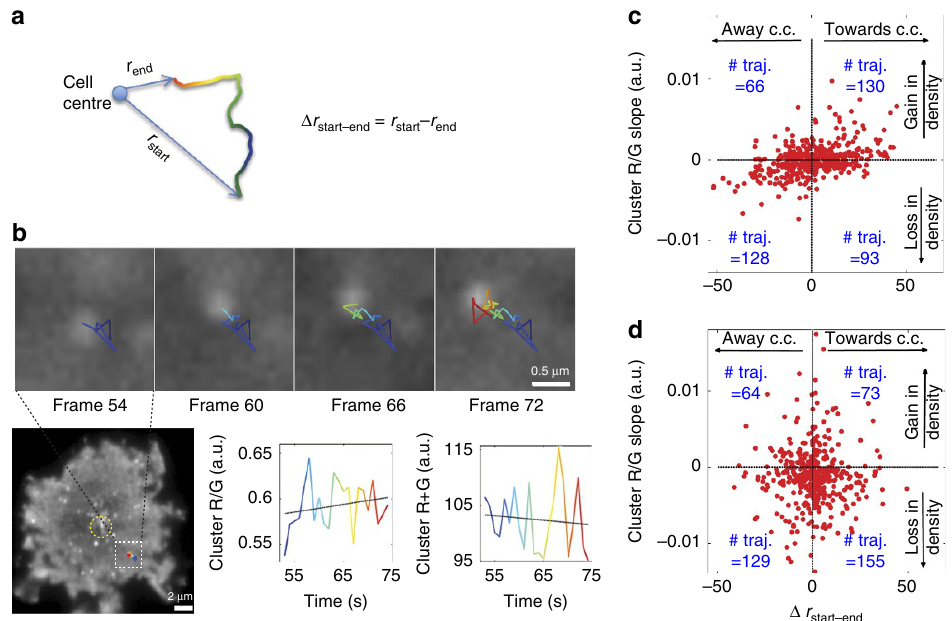
Figure 5 | Tracking TCR cluster movement and density during T-cell activation. ( a ) Tracking analysis to determine directionality of CD3 z -CliF clusters: D r start-end measures cluster movement towards or away from the cell centre. The trajectory is colour-coded from blue to red to indicate positions over time. ( b ) Representative trajectory of a CD3 z -CliF cluster (white dotted square in cell image) some distance from the cell centre (yellow circle in cell image) and the resulting R/G and R þ G traces for this trajectory. The slopes of the R/G and R þ G trajectories were extracted (black line) by linear regression. Scale bar, 2 m m, and 0.5 m m in the zoomed in images in b . ( c , d ) Scatter plot of the R/G slopes versus the D r start-end values of B 400 TCR trajectories for cells activated on pMHC-presenting lipid bilayers ( c ) and antibody (anti-CD3 þ anti-CD28 Ab)-coated surfaces ( d ). Scatter plots were divided into four quadrants, corresponding to gain/loss of cluster density and movement to/away from cell centre (c.c.). The number of trajectories in each quadrant is stated. Data shown in c , d is analysis from a single cell. 5 cells were analysed under each